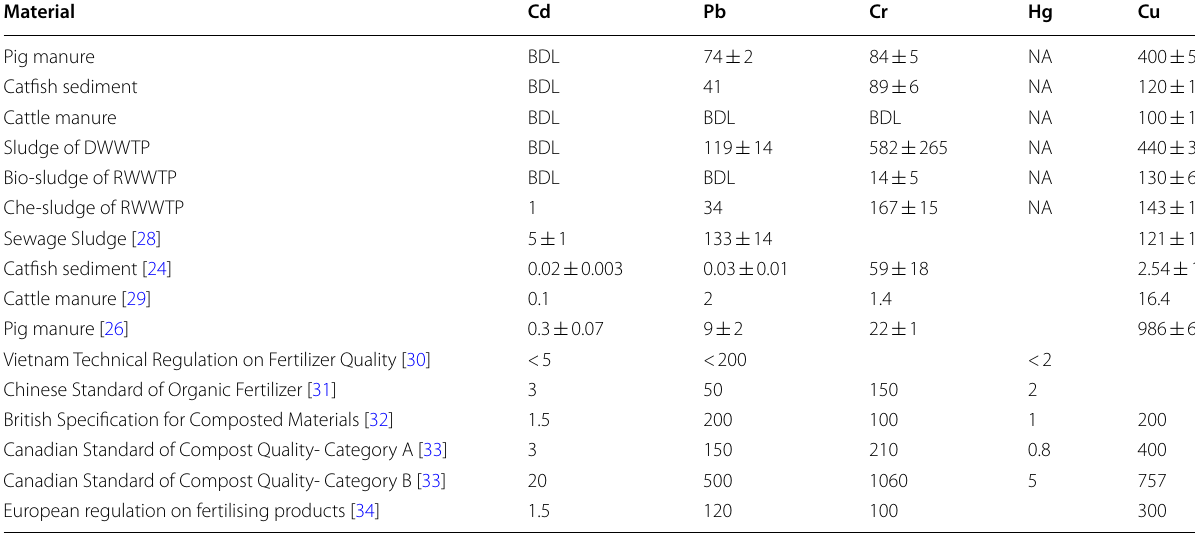
Table 4 Heavy metal contents in mg kg −